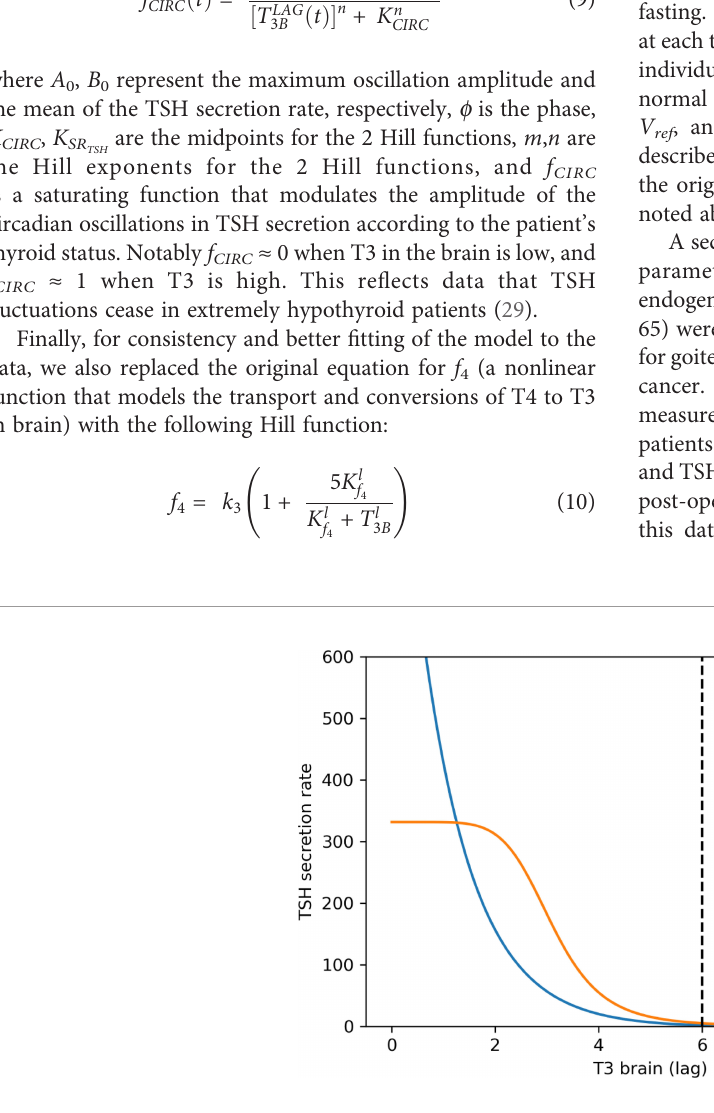
FIGURE 1 | p-THYROSIM (orange) vs. original THYROSIM (blue) TSH secretion rates ( m mol/h) versus T3 lag ( m mol) in the brain (20). The new TSH secretion function saturates at extremely low T3 values [using Equations (8 –